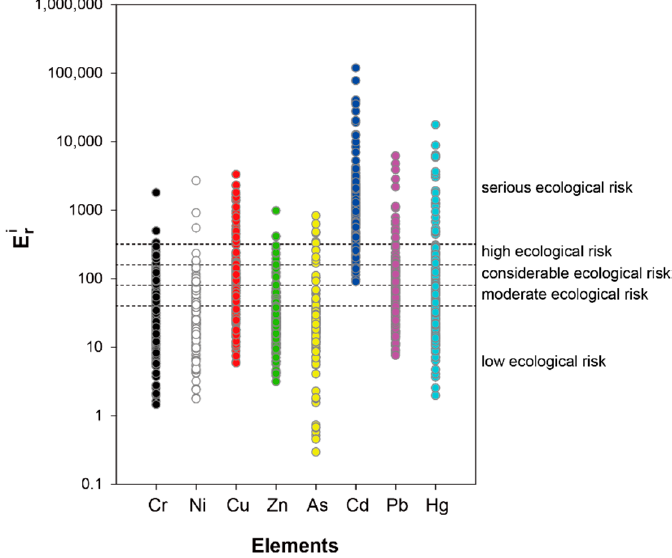
Figure 3. Ecological risk factors ( E ri ) of individual toxic elements in RD samples in this study.